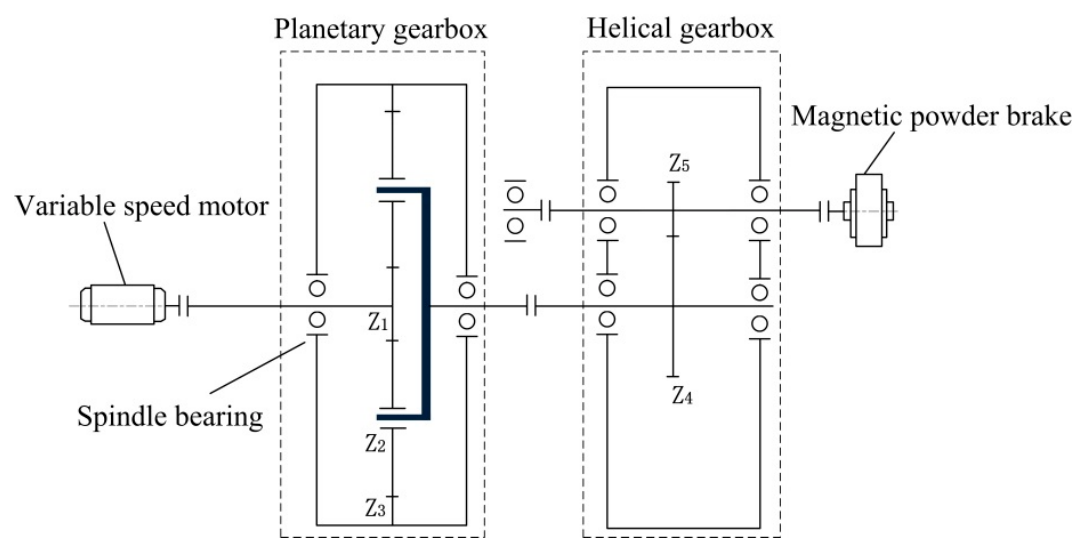
Figure 12. The structure of experimental rig.